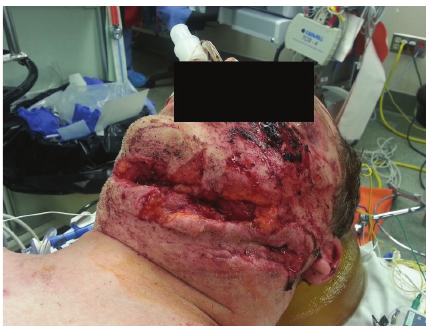
Figure 2: Intraoperative photo highlighting extent of facial trauma.